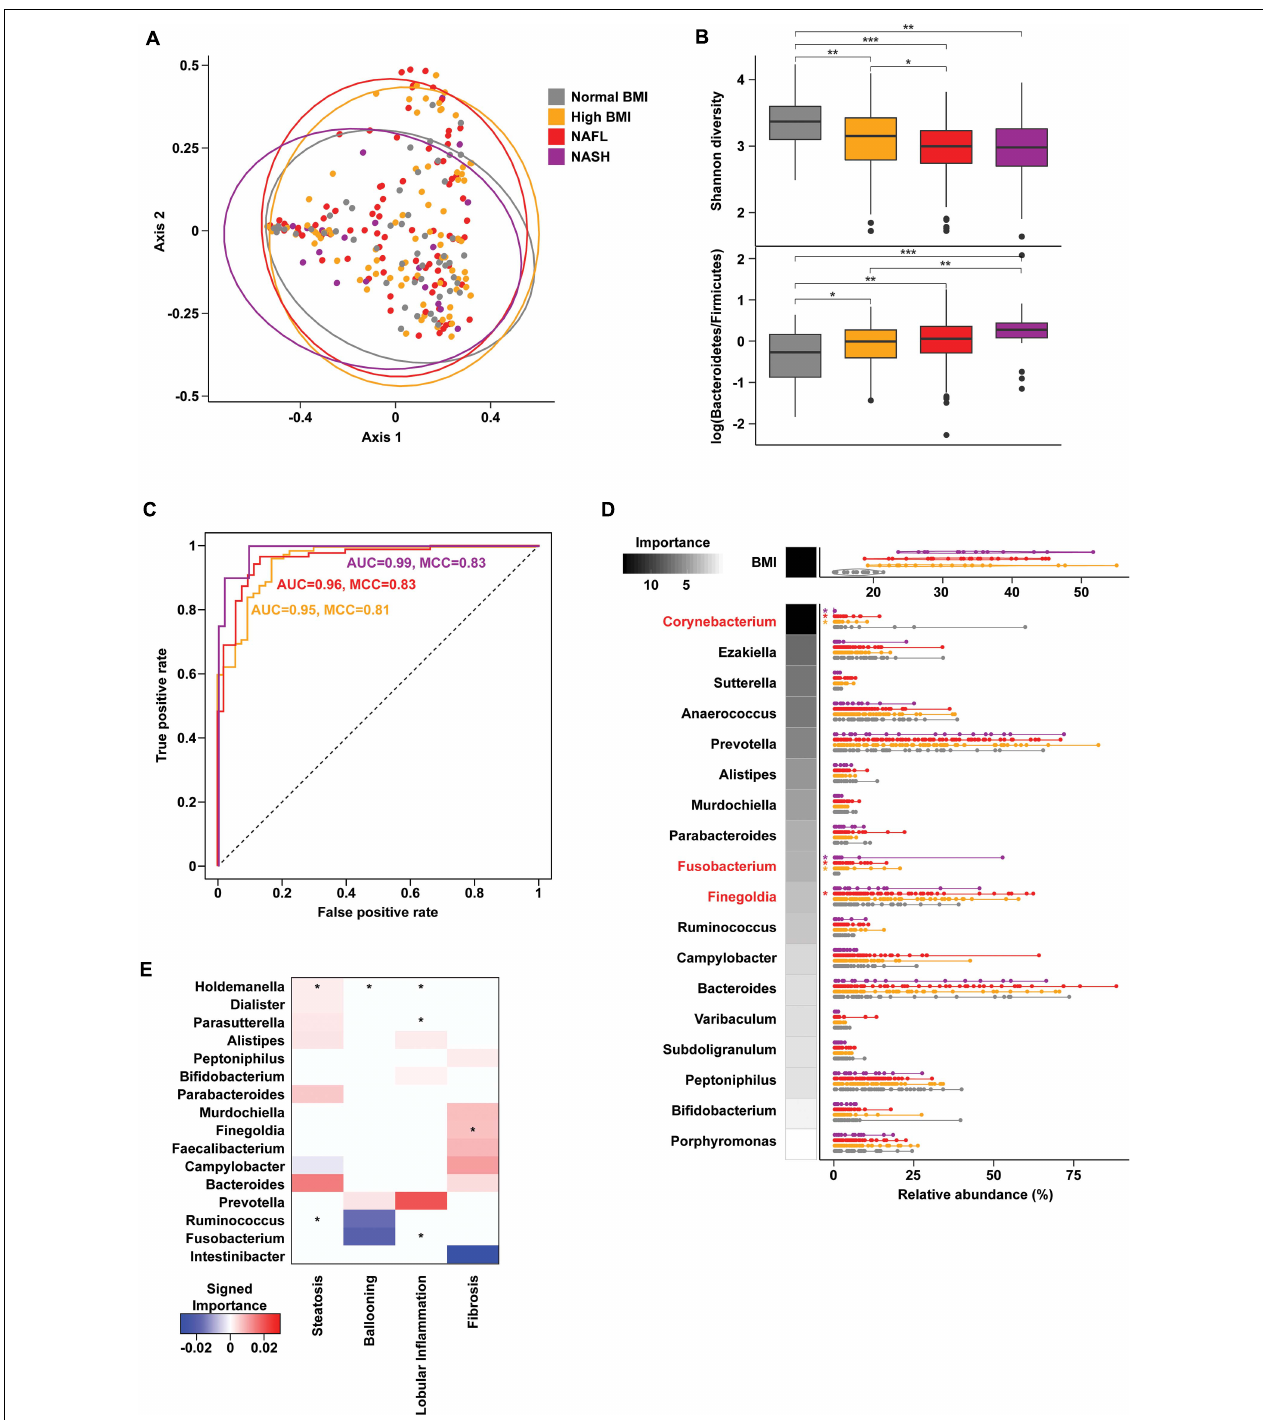
FIGURE 1 | Gut microbiome composition in progressive fatty liver disease. (A) Principal coordinates analysis (PCoA) plot of gut microbiota composition using Bray-Curtis distances. Ellipses show 95% confidence regions. (B) Boxplots show significantly decreased Shannon diversity (KW p = 3.06e-06) (top) and increased log-transformed Bacteroidetes to Firmicutes ratio (KW p = 0.001) (bottom) with advancing liver disease. Pairwise comparisons using a Wilcoxon test are indicated along the top. * p < 0.05, ** p < 0.01, and *** p < 0.001. (C) Receiver operating characteristic (ROC) curves of binary random forests (RF) classification models for each group as indicated vs. “normal BMI” baseline. (D) Distribution of BMI and genus-level relative abundances for the features selected in the multiclass RF model (violin plots). RF model importance values are shown as shaded boxes. Red text denotes genera identified as significantly altered in zero inflated negative binomial (ZINB) regression models. (E) Importance values for RF models of liver histology findings. Positive (red) and negative (blue) values indicate genera that are increased and decreased with higher grades of each finding, respectively. Asterisks (*) denote genera that are also significant ( p < 0.1) in ZINB regression analyses.